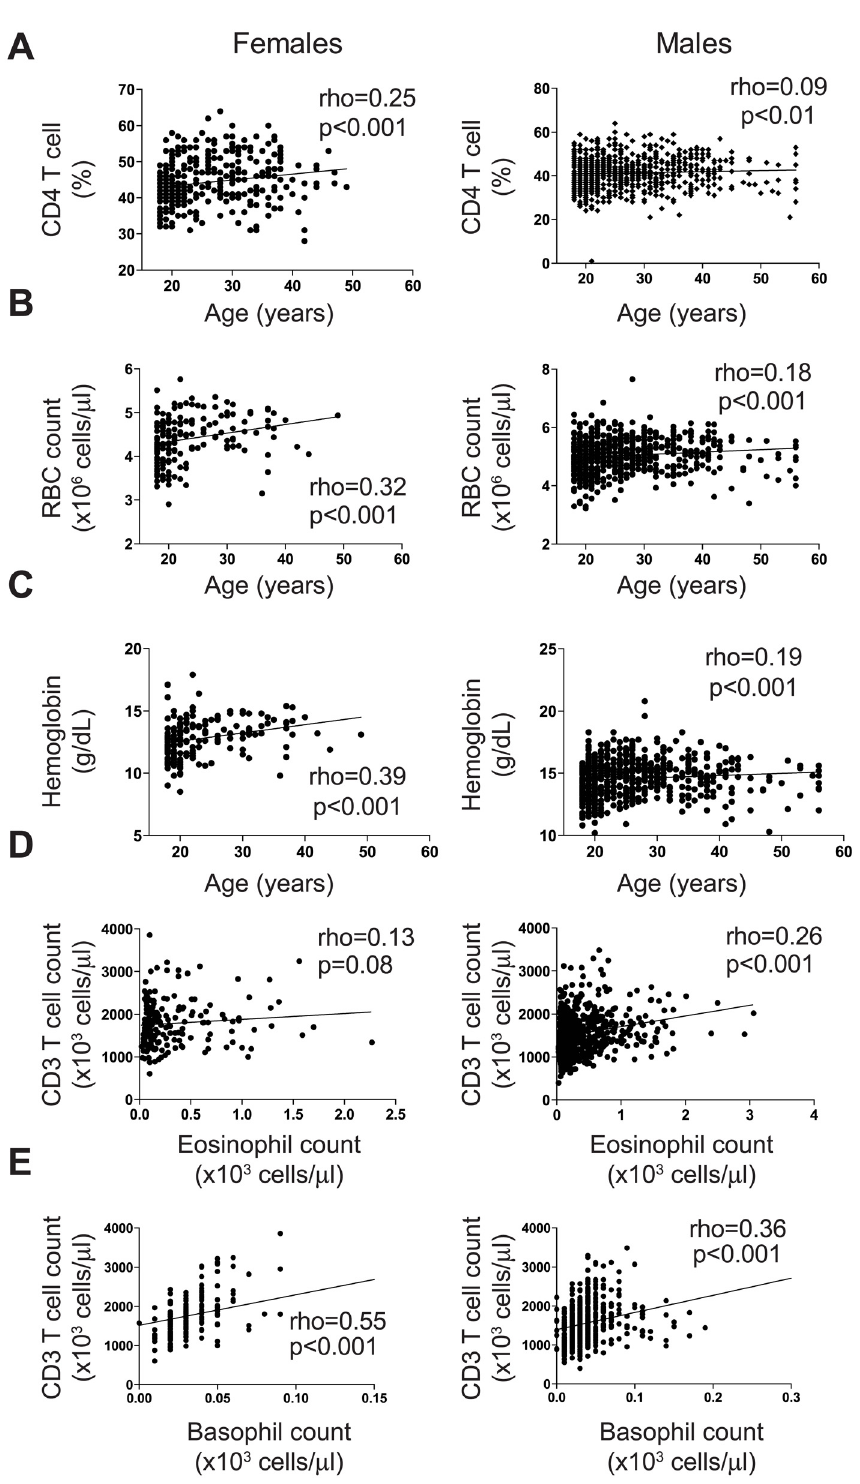
Fig 3. Association between age, lymphocytes and hematological parameters. Correlation graphs of (A) Age and CD4 T cell frequency; (B) Age and RBC count; (C) Age and hemoglobin levels; (D) eosinophil and CD3 T cell counts; and (E) basophil and CD3 T cell counts. The Spearman ’ s rank correlation was used to assess associations between parameters, with rho (cid:1) 0.25 and p values < 0.05 considered statistically